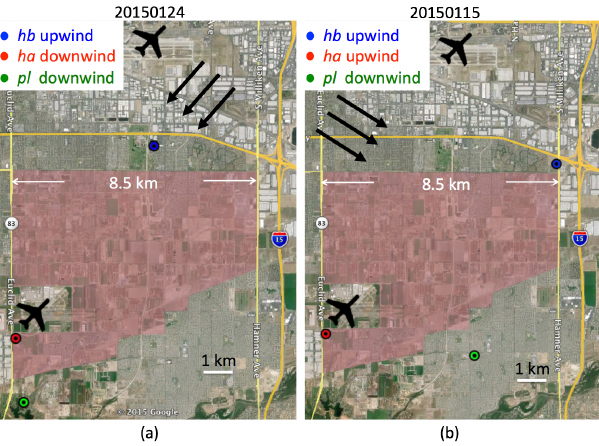
Figure 3. Locations of FTS stations and mean wind directions on 24 January 2015 (a) and 15 January 2015 (b) . Map provided by Google Earth, Image Landsat, Data SIO, NOAA, US Navy, NGA, and